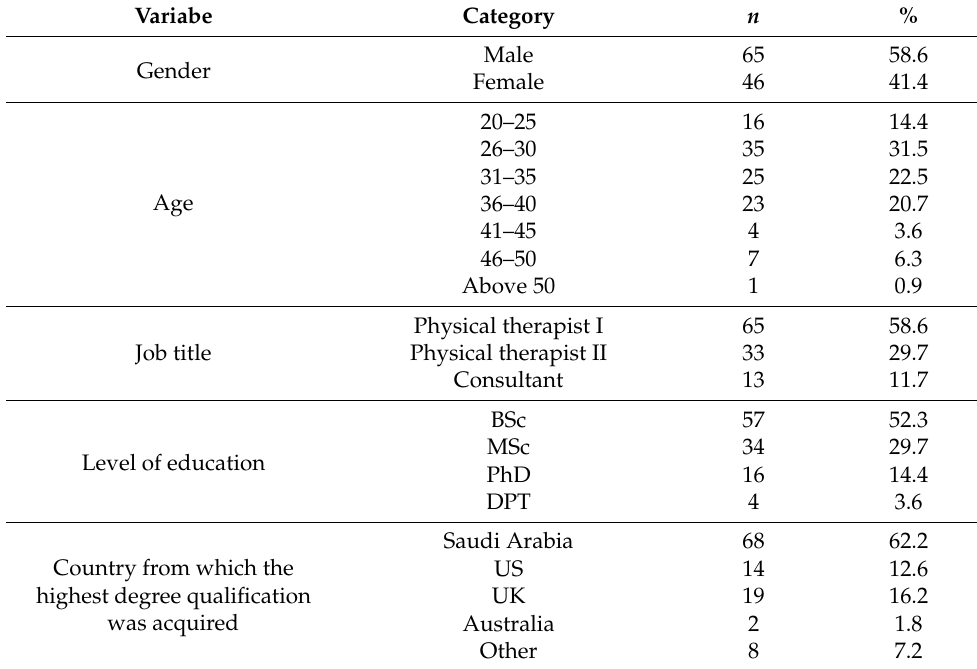
Table 1. Personal and professional characteristics of physical